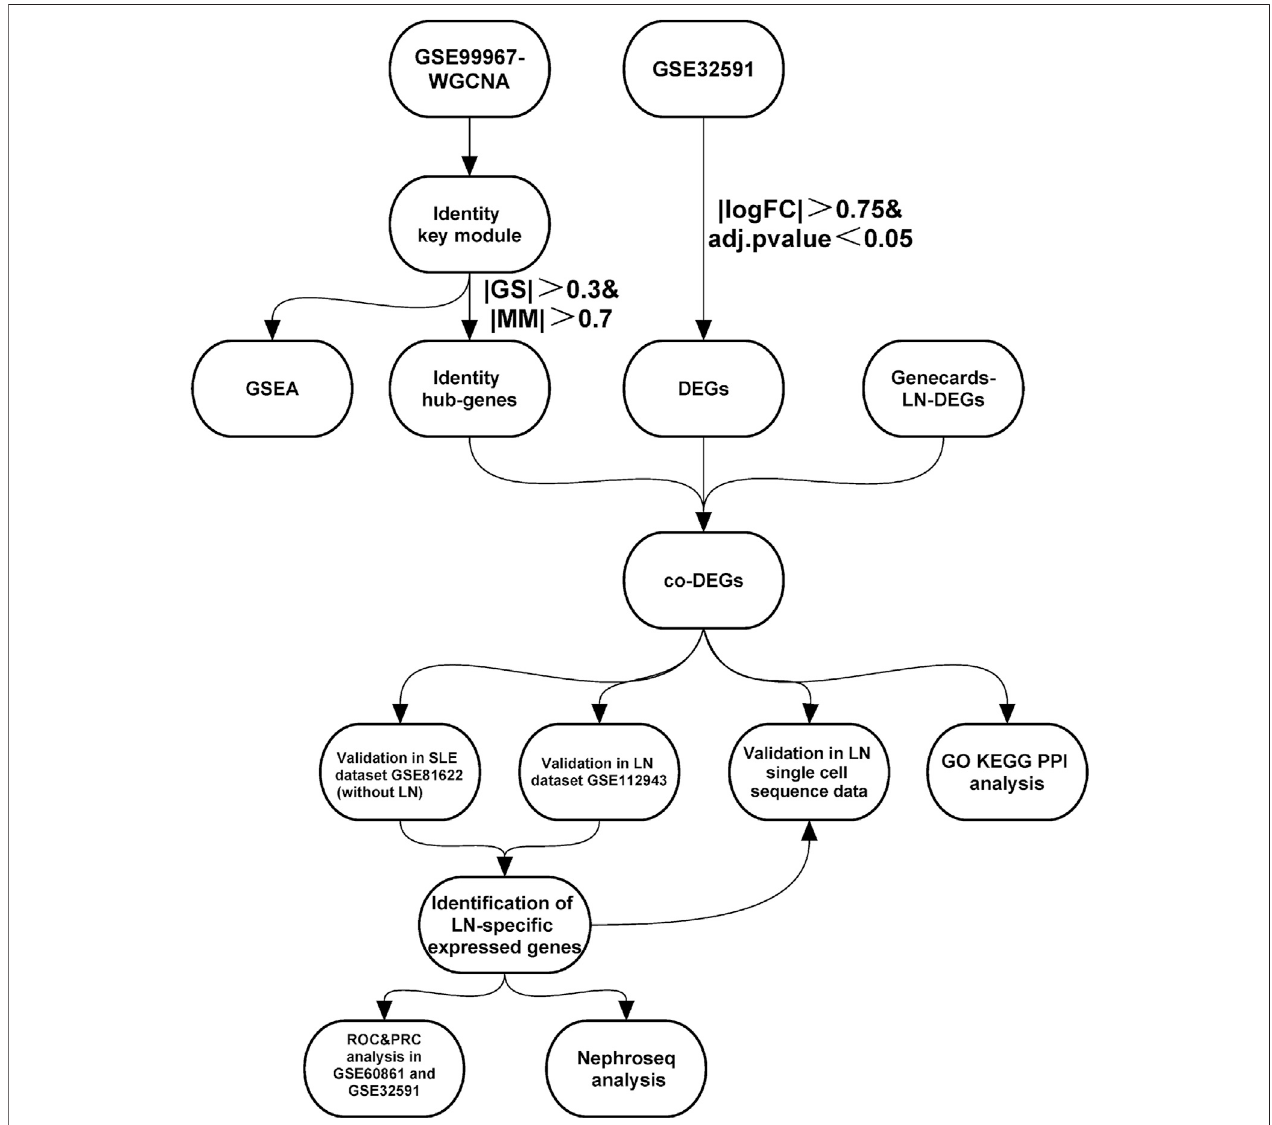
FIGURE1|| Studywork fl ow.Abbreviations:Systemiclupuserythematosus(SLE);Lupusnephritis(LN);Weightedgeneco-expressionnetworkanalysis(WGCNA); Gene set enrichment analysis (GSEA); Differentially-expressed genes (DEGs); Gene ontology (GO); Kyoto encyclopedia of genes and genomes (KEGG); Protein-Protein interaction (PPI); Receiver operating characteristic curve (ROC); Precision-Recall curve (PRC).